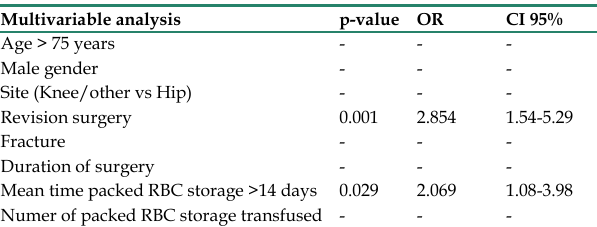
Table 3. Step-wise forward logistic regression model results of each subgroups of patients transfused during surgery or within the first 6 hours after surgery. Multivariable analysis p-value